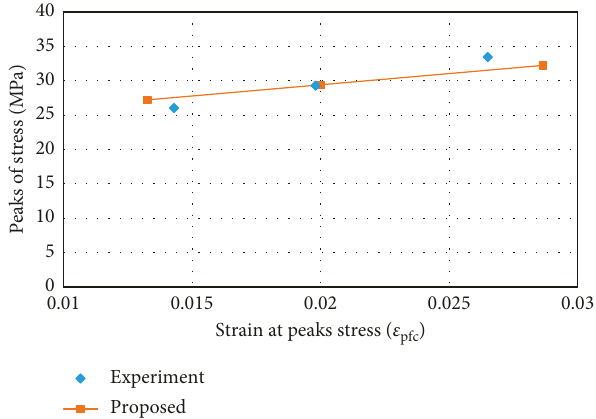
Figure 7: Comparison of peak stress versus strain at peak stress between the proposed and experimental results.